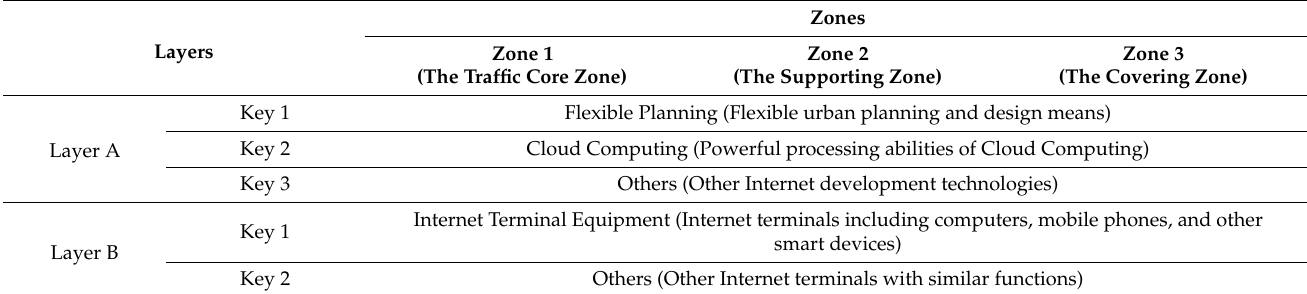
Table 6. The detailed structure matrix of